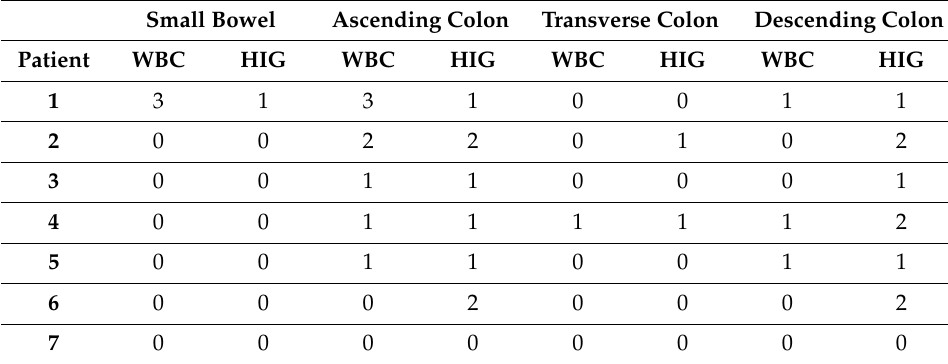
Table 2. Comparison of uptake of white blood cells (WBCs) and human polyclonal immunoglobulin G labeled with 99mTc (99mTc-HIG) in the small bowel and in ascending, transverse, and descending colon in seven patients studied by scintigraphy. Evaluation of bowel abnormalities by a 4-point scale, for each region, as follows: O = no uptake; 1 = faint uptake; 2 = intermediate uptake; 3 = strong uptake. Only the scans scoring 1, 2 or 3 were accepted as really being